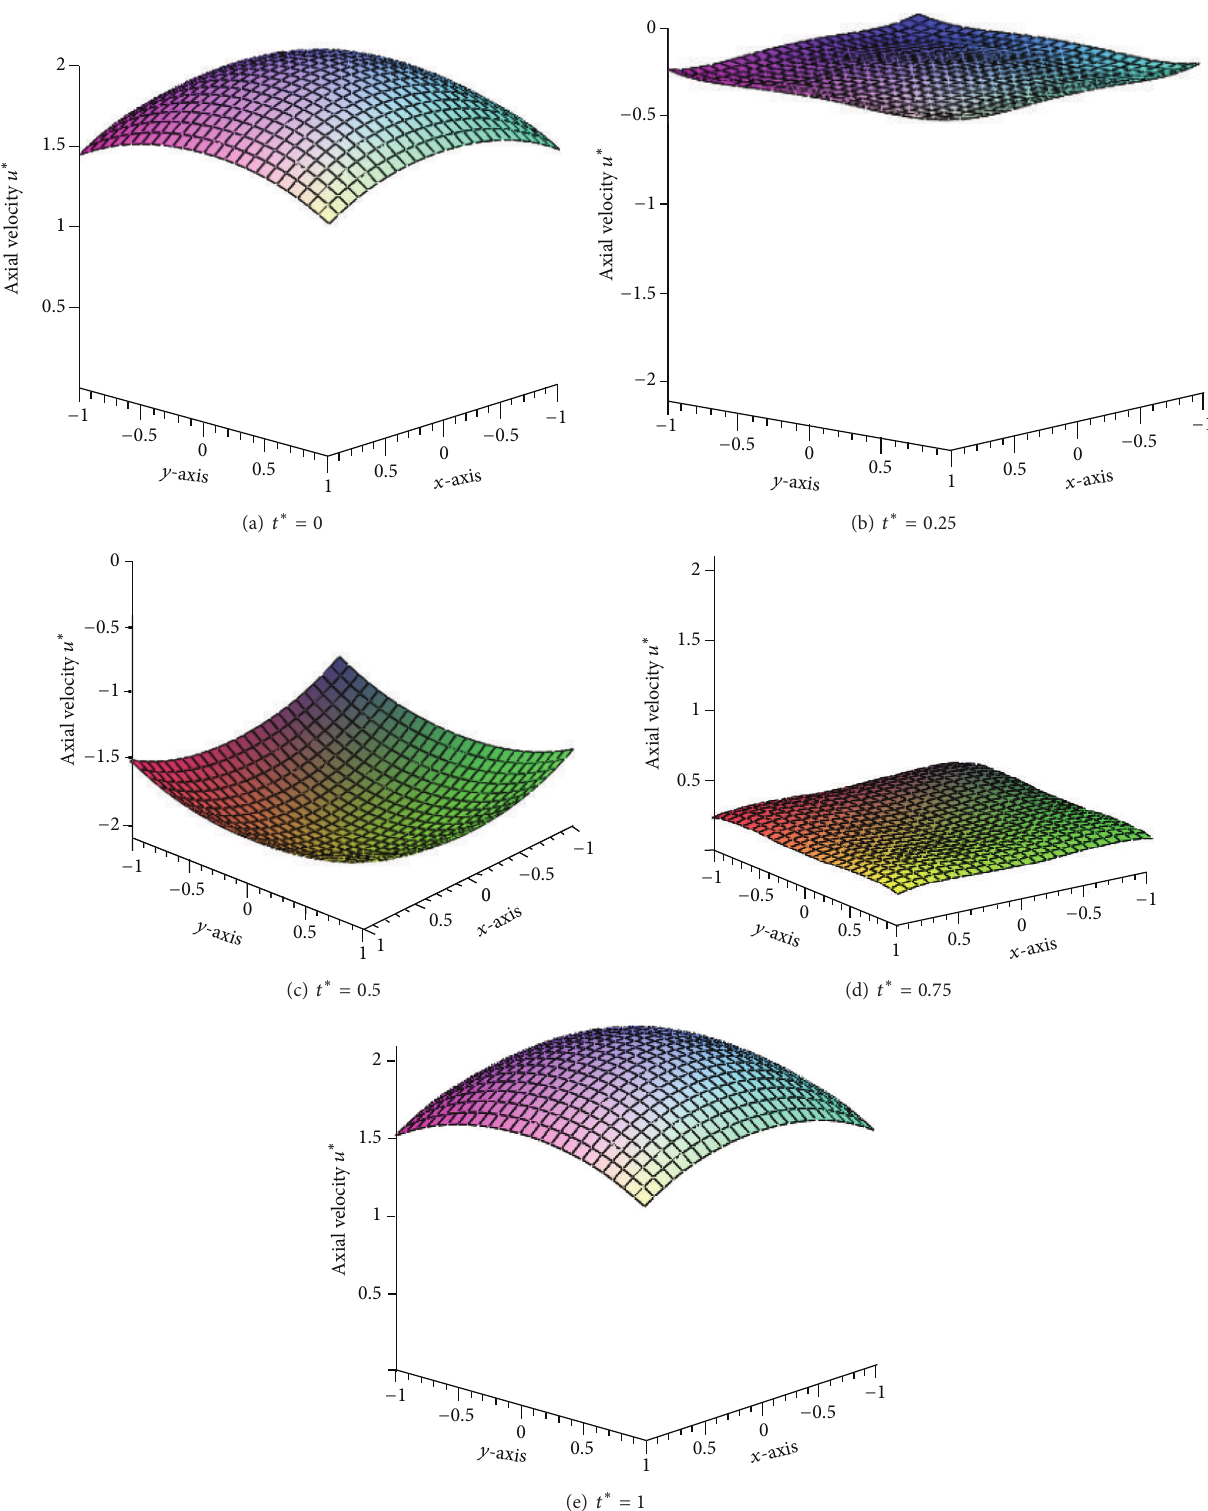
Figure 6: Axial velocity profile on the cross-section of the channel with the area of 1.0 × 10 −6 m 2 and ratio 𝑏/𝑎 = 1 under the frequency 𝜔 = 𝛼/𝜌𝑎 2 with 𝛼 = 0.005 and slip length of 0.001 for various instants of